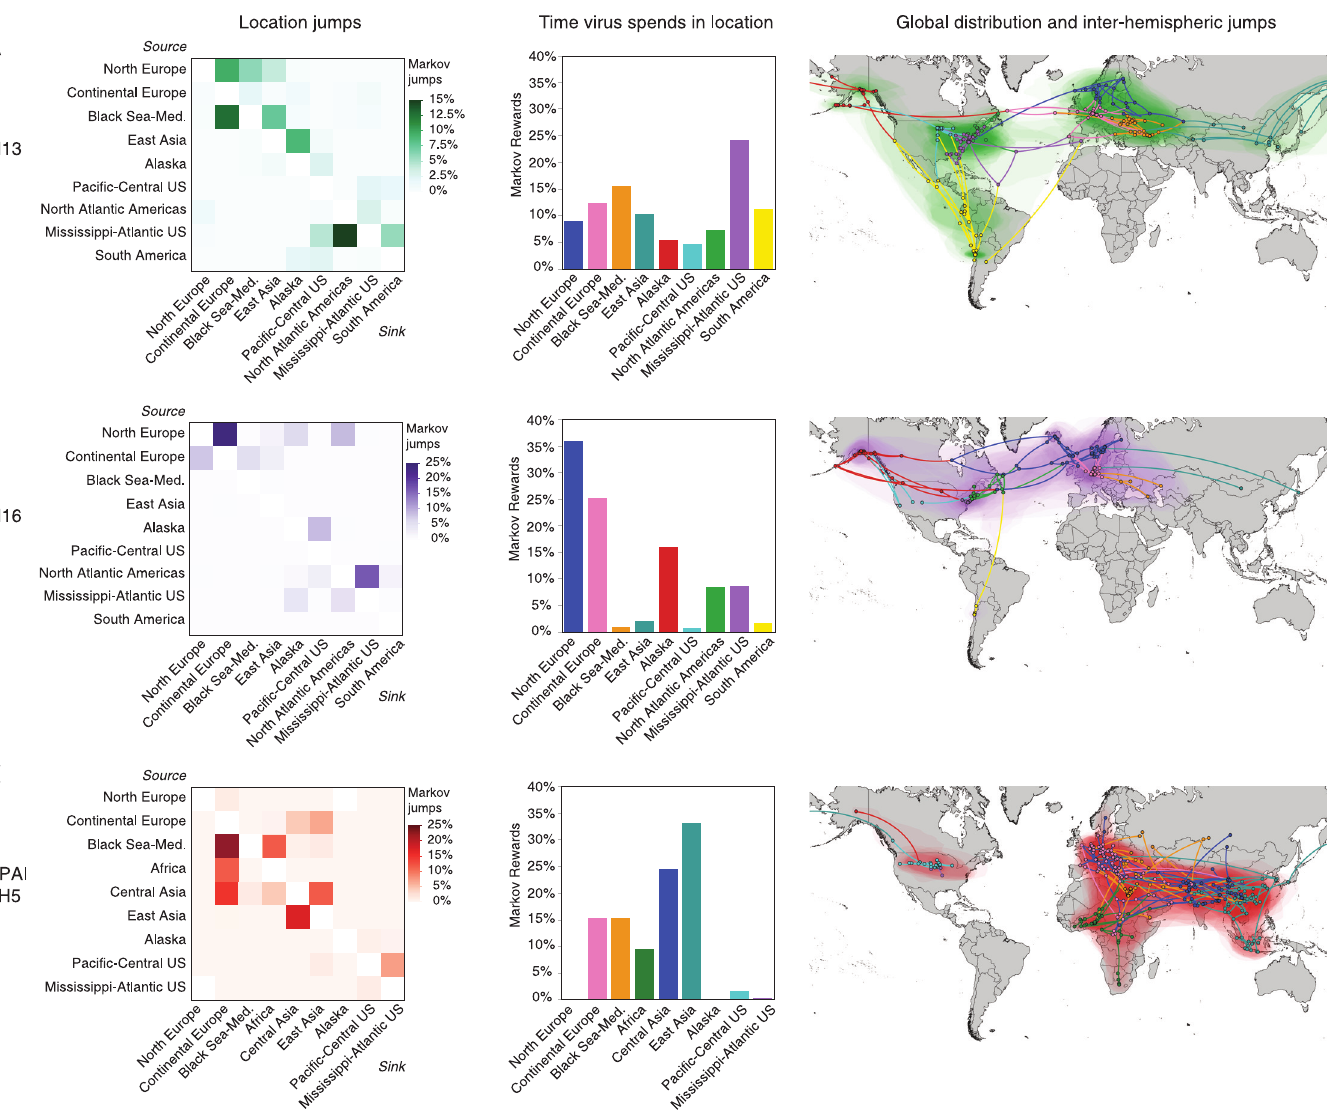
Fig 1. The contrasting pattern of geographic jumps, hotspots and global distribution of influenza A viral subtypes. The heatmaps: A) H13 (green), B) H16 (purple) and C) highly pathogenic avian influenza H5 (red), indicate the frequency of transitions between locations estimated using a discrete trait phylogenetic model and the number of location transitions was determined using Markov jumps. The proportion of time the virus spends in each location (center panel) is indicated by the bar charts with each subtype showing a uniquely different geographic distribution. The global distribution of each subtype is depicted by shading on the maps (right panel). Lines indicate the route of inter-hemispheric virus flow and represent the branching pattern of internal and external nodes of the underlying phylogenetic tree. Basemap made with Natural Earth (https://www.naturalearthdata.com).